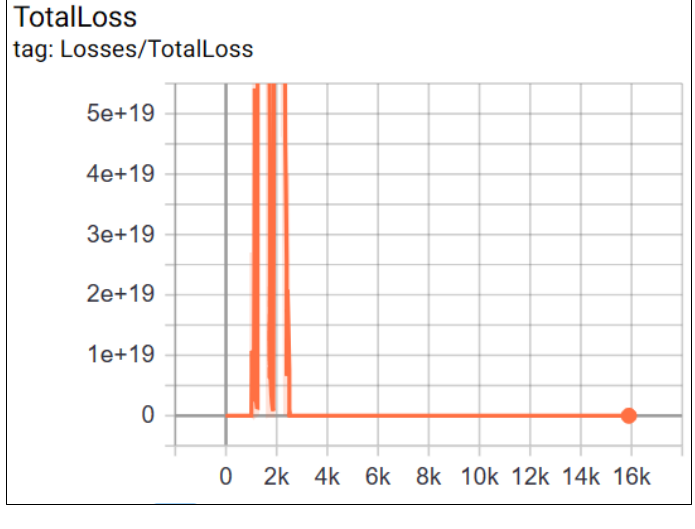
Figure 17. Total Loss